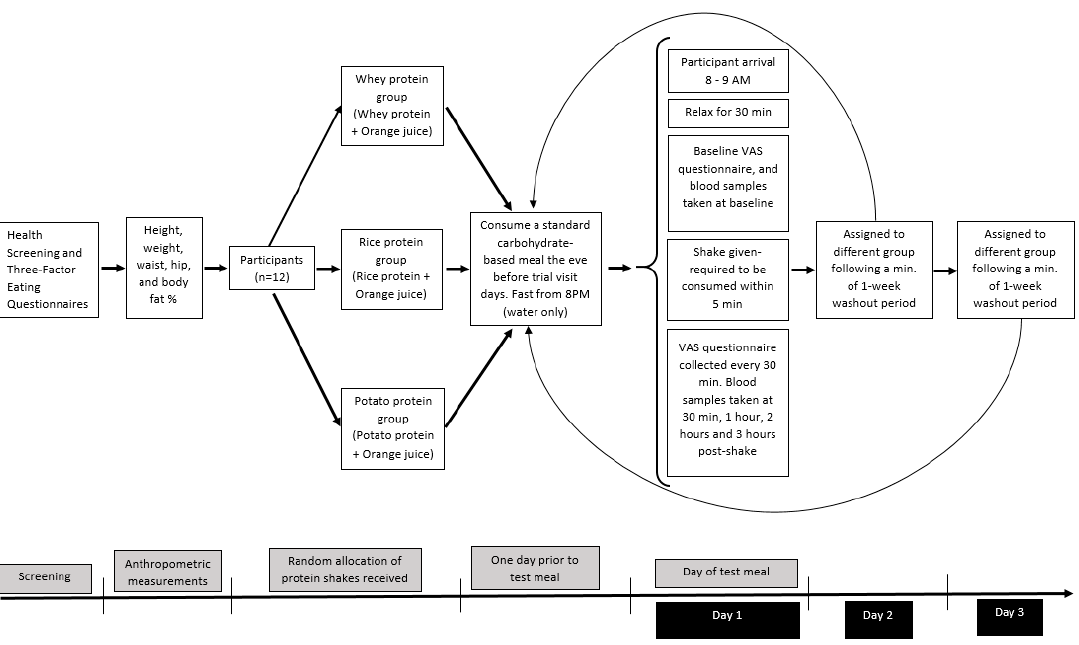
Figure 1. Overview of study design.